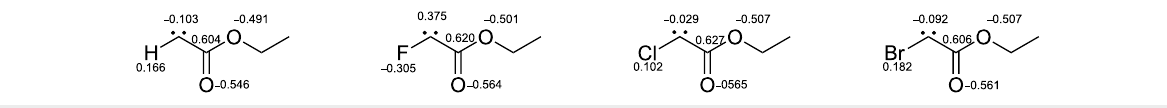
The calculations predict the following order of electrophilicity for the carbenes displayed in Figure 6: F > Cl > Br > H. The atomic charges for the carbenes generated from 2a and 2d are fairly similar to the computed values of the closely related halo carbomethoxy carbenes studied by Platz’ research group [23]. We also computed the energies of the corresponding triplet triplet electronic spin state (Figure 3). The singlet–triplet energy gap is 4.1 kcal/mol in favor of the triplet state for the EDA- generated carbene. All three carbenes generated from 2a – c on gap follows the order F > Cl > Br and is small for